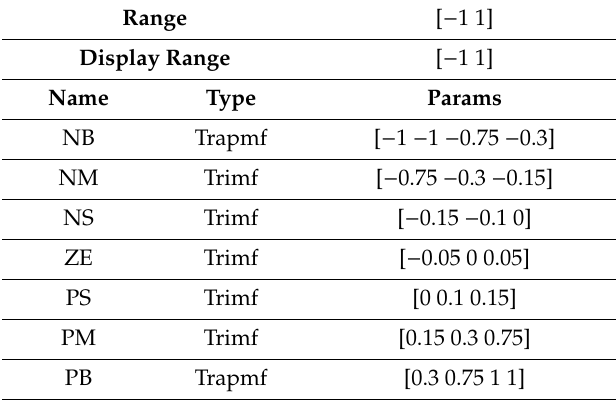
Figure 12. Rule table of fuzzy controller (49 rules). Table 4. Table of membership function for input variable “E”, “ ∆ E”, and Table 5. Fuzzy rule base table of Δ𝐾 (cid:3017) (t), Δ𝐾 (cid:3036) (t), Δ𝐾 (cid:3031) (t).